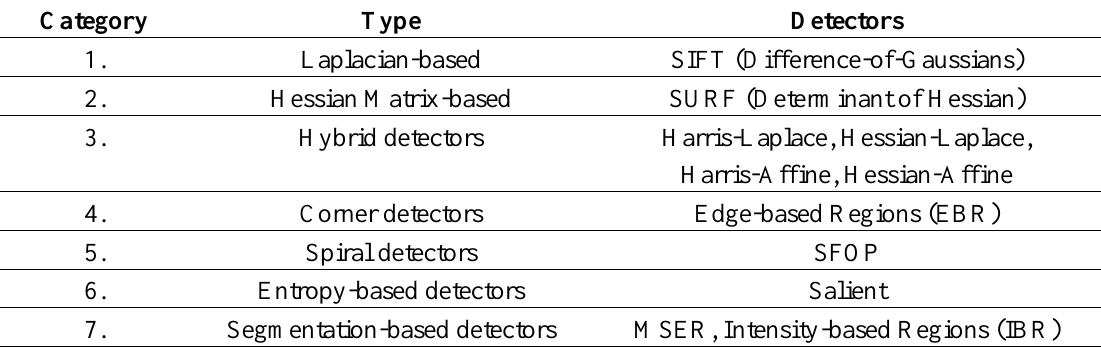
Table 4. Re-classification of state-of-the-art detectors based on results for detector pairs. Category